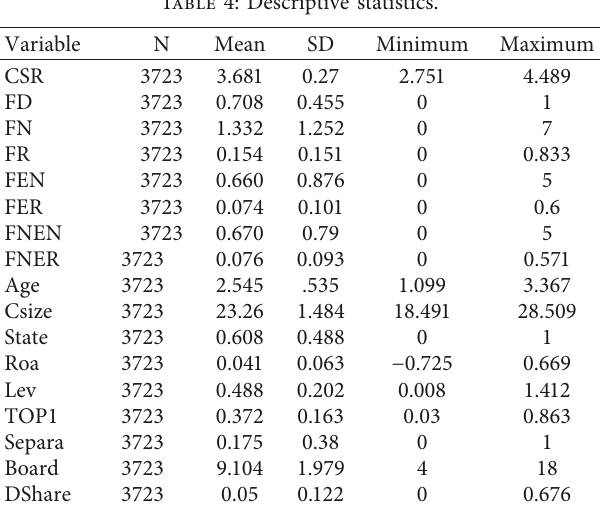
Table 4: Descriptive statistics.